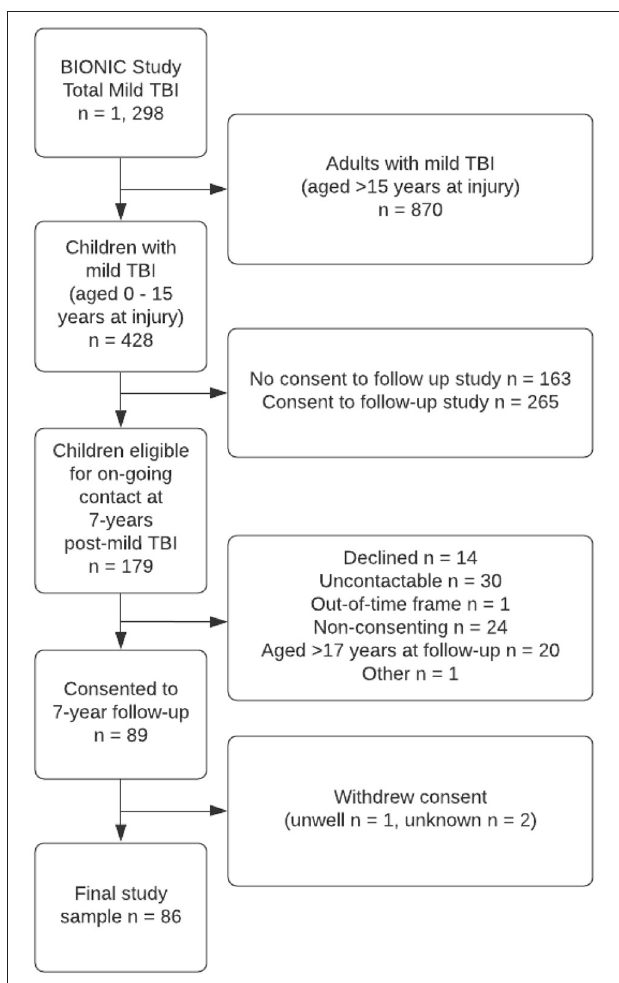
FIGURE 1 | Case participation flow